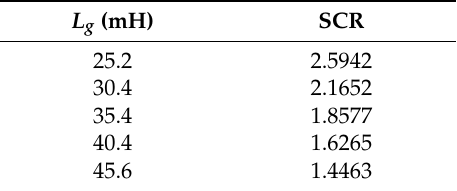
Table 3. SCRs Used in this